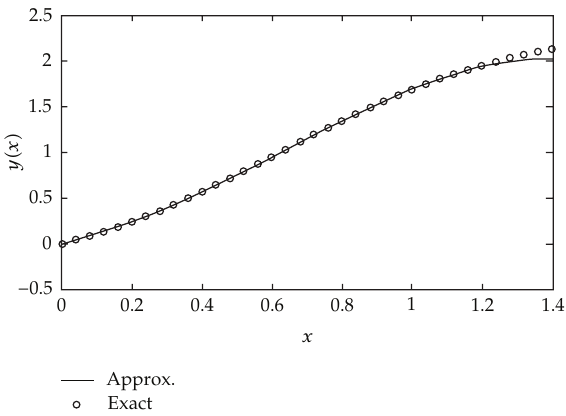
Figure 3: The graph indicates the solution y (cid:3) x (cid:4) for (cid:3) 4.11 (cid:4) , when α (cid:7) 1.